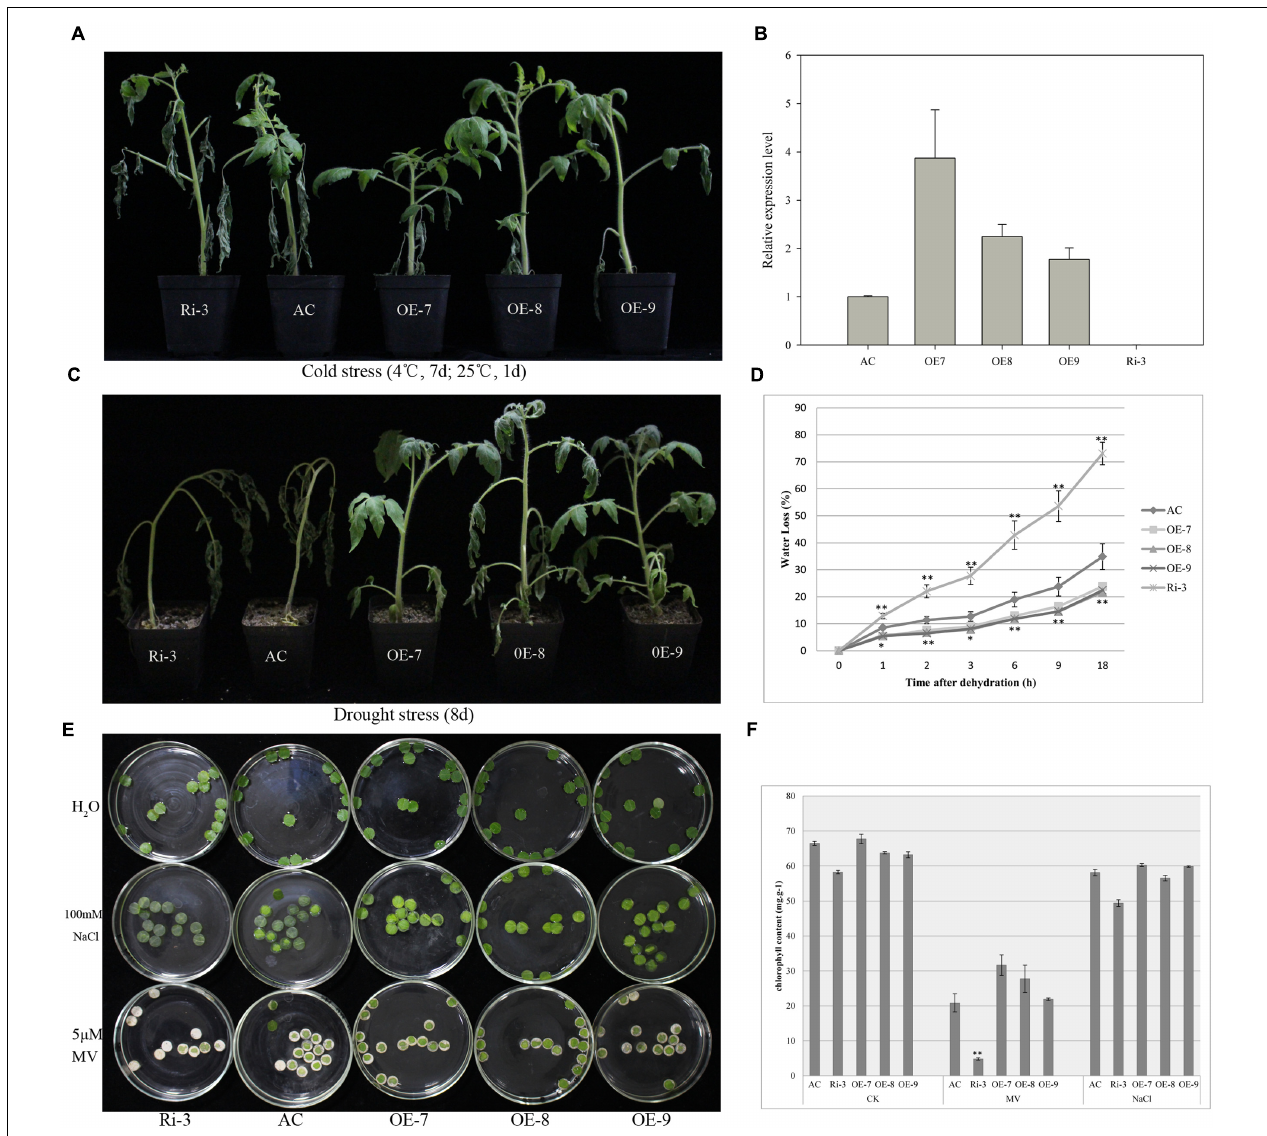
FIGURE 3 | Overexpression of ShATL78L enhanced the tolerance to multiple abiotic stresses in tomato. (A) Phenotypes of seedlings from transgenic and wild-type tomato plants under cold stress conditions. Four-week-old seedlings of transgenic lines (T2 generation) and wild-type were treated at 4 ◦ C for 7 days and then recovered at 25 ◦ C for 1 day. (B) Relative expression level of ATL78L in the wild-type and transgenic lines. (C) Phenotypes of seedlings from transgenic lines and wild-type under drought stress conditions. Four-week-old seedlings of transgenic lines (T 2 generation) and wild-type were withheld from water for 8 days. (D) Water loss of the detached leaves from wild-type and transgenic plants. (E) Leaf disks obtained from 4-week-old wild-type and transgenic seedlings were incubated in different solution of H 2 O, 100 mM NaCl and 5 µ M MV for 72 h. (F) Relative chlorophyll content after the 100 mM NaCl and 5 µ M MV treatment of the leaf disks. Data in (B,D,F) are means ± SE of three biologically replicated samples. AC represents the wild-type. OE-7, OE-8, OE-9, and Ri-3 represent three independent ShATL78L overexpression lines and the RNAi line, respectively. Asterisks indicate significant differences between transgenic lines and wild-type ( ∗ P < 0.05; ∗∗ P < 0.01, Student’s t